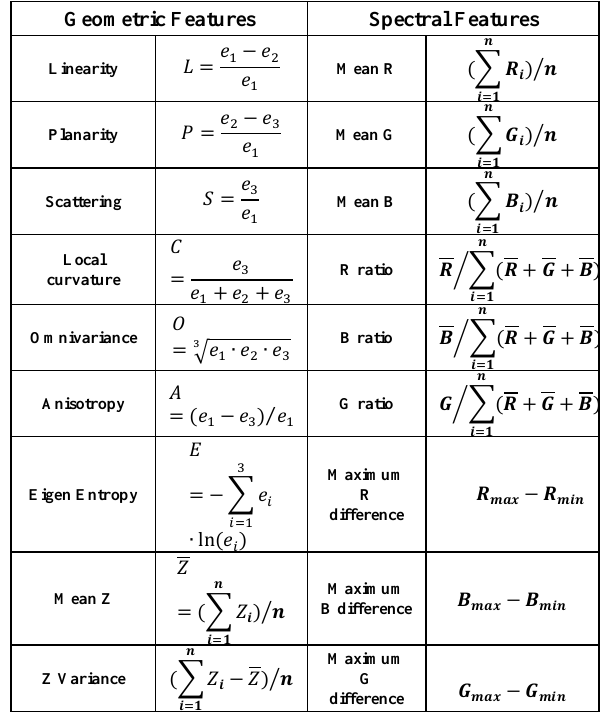
Table 3 . Geometric and spectral features that are used in classification